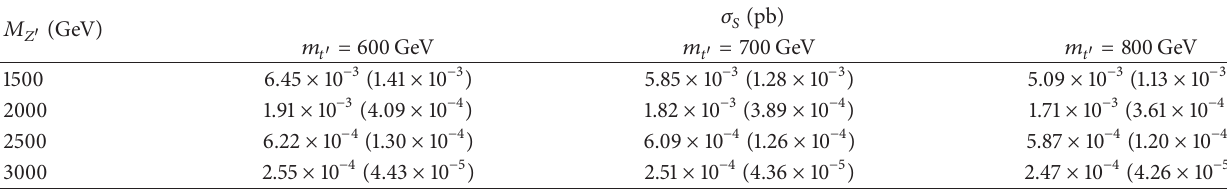
Table 6: The same as Table 3, but for 𝑥 = 0.5 .